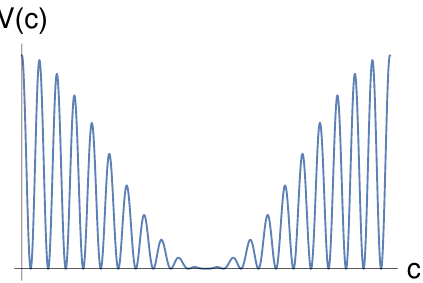
Figure 10 . The axion potential of example 2 for the case M = 10. There are sub-Planckian oscillations within a long super-Planckian